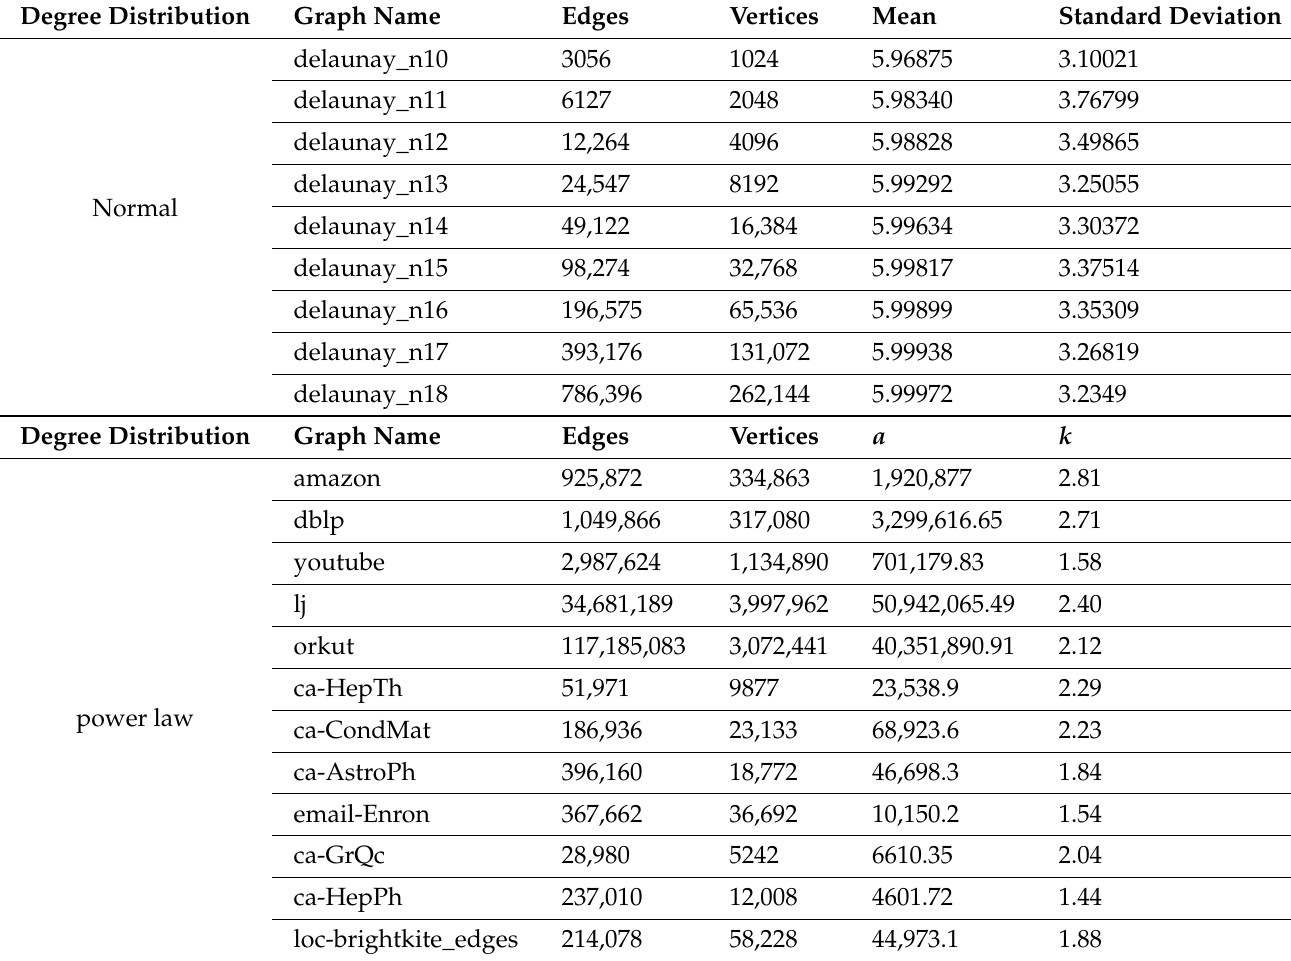
Table 3. Graph benchmarks utilized for the triangle counting